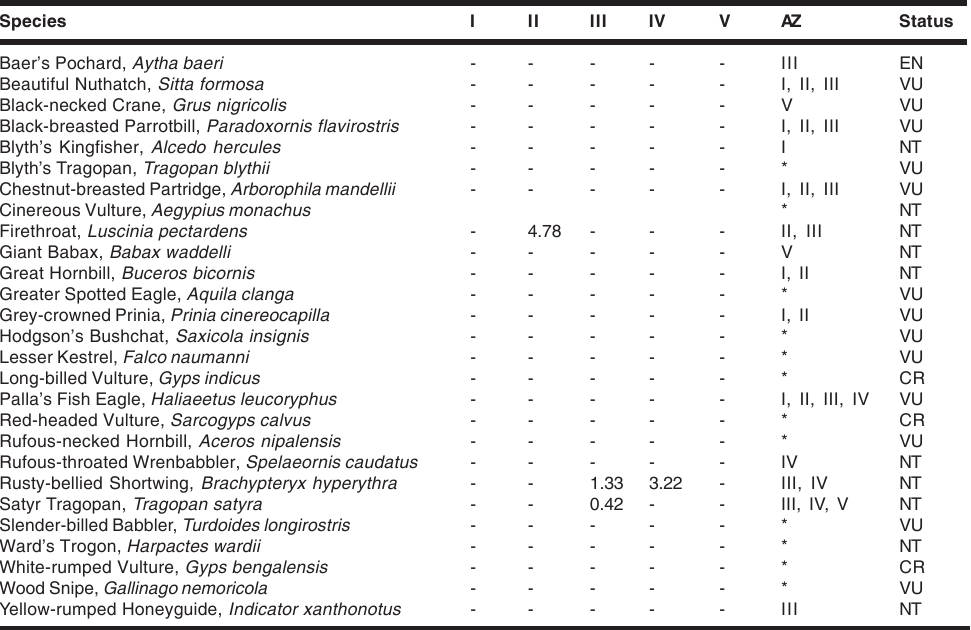
AZ - reported altitude zone for species; - - denotes species not observed during the present study; * - distribution of species not known; EN - Endangered; CR - Critically Endangered; VU - Vulnerable; NT - Near